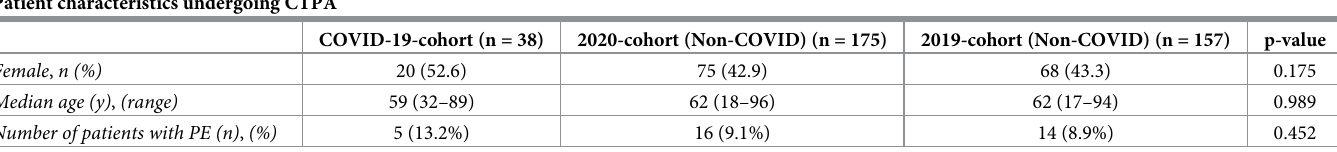
Table 2. Patient characteristics. Number of patients (n), Years (y), Pulmonary embolism (PE). Patient characteristics undergoing